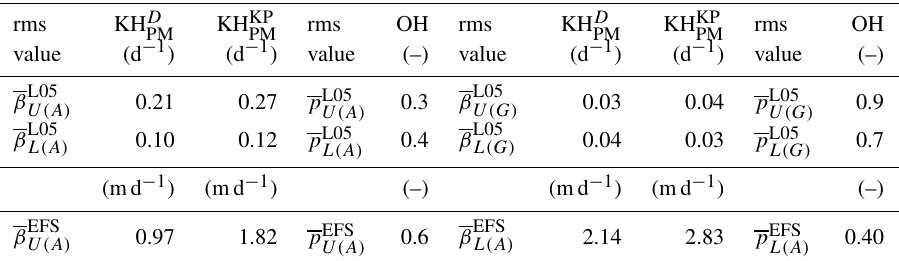
Figure 2. Comparison of lower-bound predictability curves E norm ,L of the ECMWF forecasting system normalized by E EFS ∞ (EFS; annual arithmetic means, representative samples from1986–2011) and the L05 system normalized by E L05 ∞ mean). Table 4. The rms values calculated over all initial errors used for the L05 system ( N = 90) and over all years for the ECMWF forecasting system of parameters β and p (for description see Table